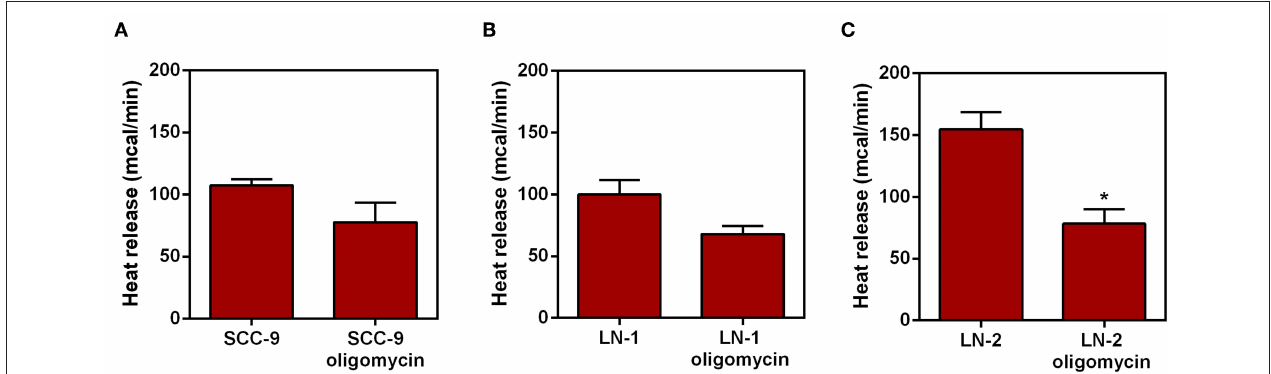
FIGURE 6 | Effect of oligomycin on heat release by human oral squamous carcinoma cells SCC-9, LN-1 and LN-2. The bars represent the release of total heat of living cells in 35min of experiment. (A) Heat release by SCC-9 cells untreated and treated with oligomycin 2 µ g/mL; (B) heat release by LN-1 cells untreated and treated with oligomycin 2 µ g/mL. (C) Heat release by LN-2 cells untreated and treated with oligomycin 2 µ g/mL. Values were expressed as mean ± SEM. * p <